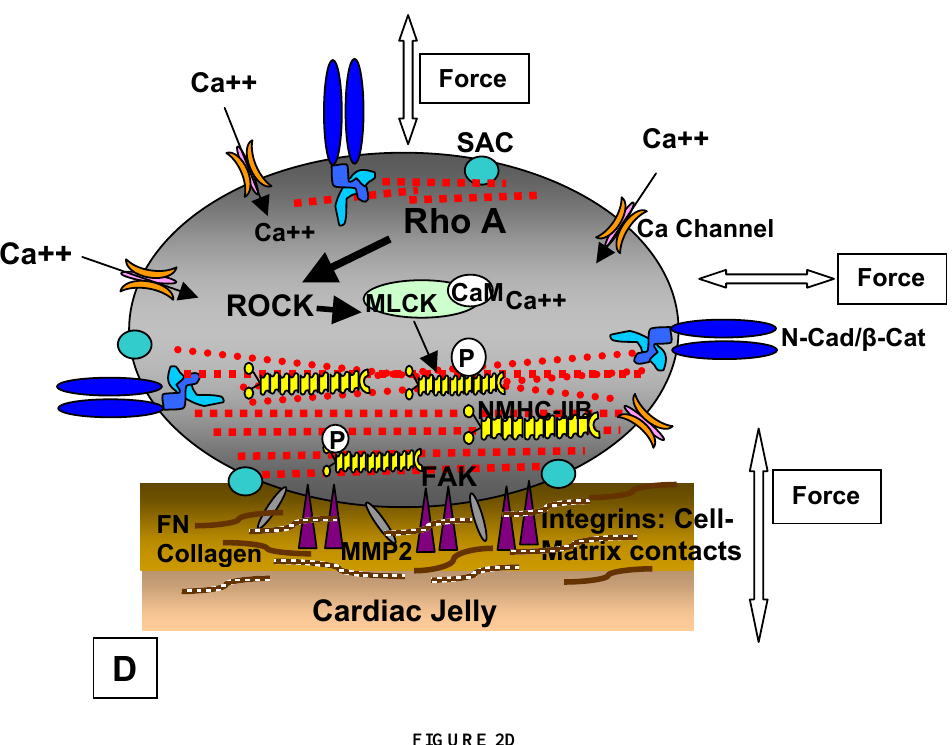
FIGURE 2 cont. Panel 2D, depicts the subcellular cytoskeletal-mediated mechanisms in the inner myocardial wall by which focal adhesion kinase (FAK) at the basal side mediates integrin-, and its role in cyclic stretch, signaling in association with the cytoskeleton. Small cardiomyocyte cell processes are shown extending into the basal lamina (see also Fig. 6). MMP-2 is thought to interact within the ECM in the microenvironment to release activating factors that can bind to cell surface receptors, as well as lead to ECM degradation. N-cadherin/ β - catenin complex functions in association with connexins and regulates cyclic stretch by its interactions with the cytoskeleton, as well as neighboring cells through mediation of cell-cell adhesion. Rho proteins, ROCK, Ca++/calmodulin (CaM), regulate force through phosphorylation of nonmuscle myosin light chain via myosin light chain kinase (MLCK), as well as phophorylation of other cytoskeletal proteins. In addition to the depicted calcium channels shown are stretch activated channels (SAC) that are known to be expressed in the embryonic chick heart [ 119 ]. Cation selective (Ca++ and Ba++) SACs can provide mechanosensitivity when a cell is mechanically stimulated and are proposed to be anchored to the cortical cytoskeleton and possibly to the